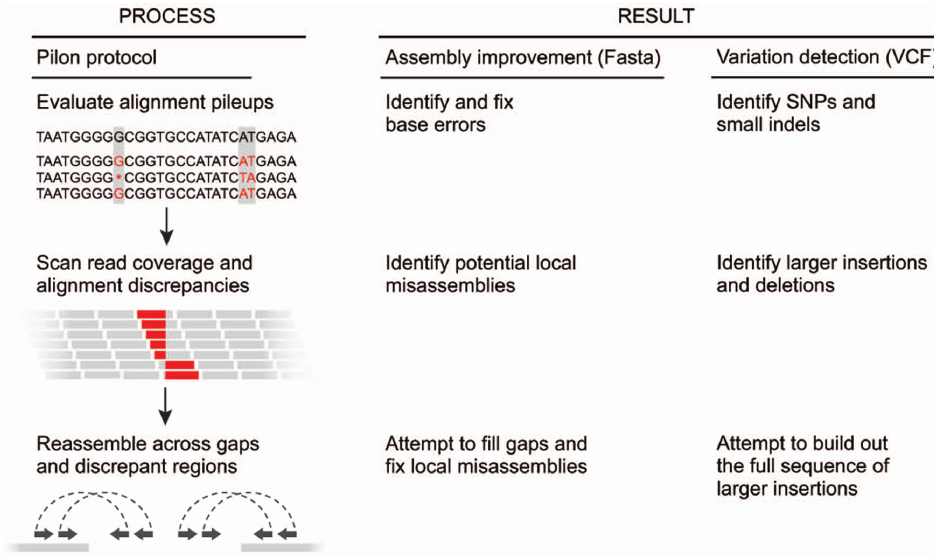
Figure 1. Simplified overview of the Pilon workflow for assembly improvement and variant detection. The left column depicts the conceptual steps of the Pilon process, and the center and right columns describe what Pilon does at each step while in assembly improvement and variant detection modes, respectively. During the first step (top row), Pilon scans the read alignments for evidence where the sequencing data disagree with the input genome and makes corrections to small errors and detects small variants. During the second step (second row), Pilon looks for coverage and alignment discrepancies to identify potential mis-assemblies and larger variants. Finally (bottom row), Pilon uses reads and mate pairs which are anchored to the flanks of discrepant regions and gaps in the input genome to reassemble the area, attempting to fill in the true sequence including large insertions. The resulting output is an improved assembly and/or a VCF file of variants.